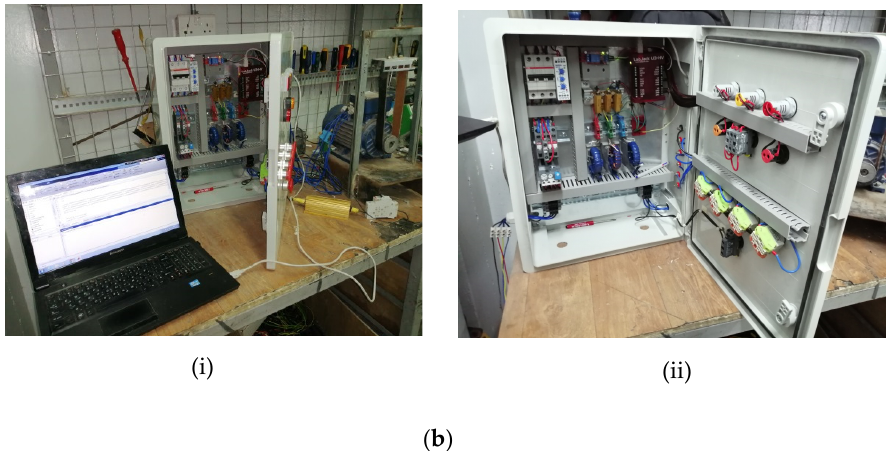
Figure 23. The implemented system ( a ) Block diagram, and ( b ) practical implementation of the protection system.